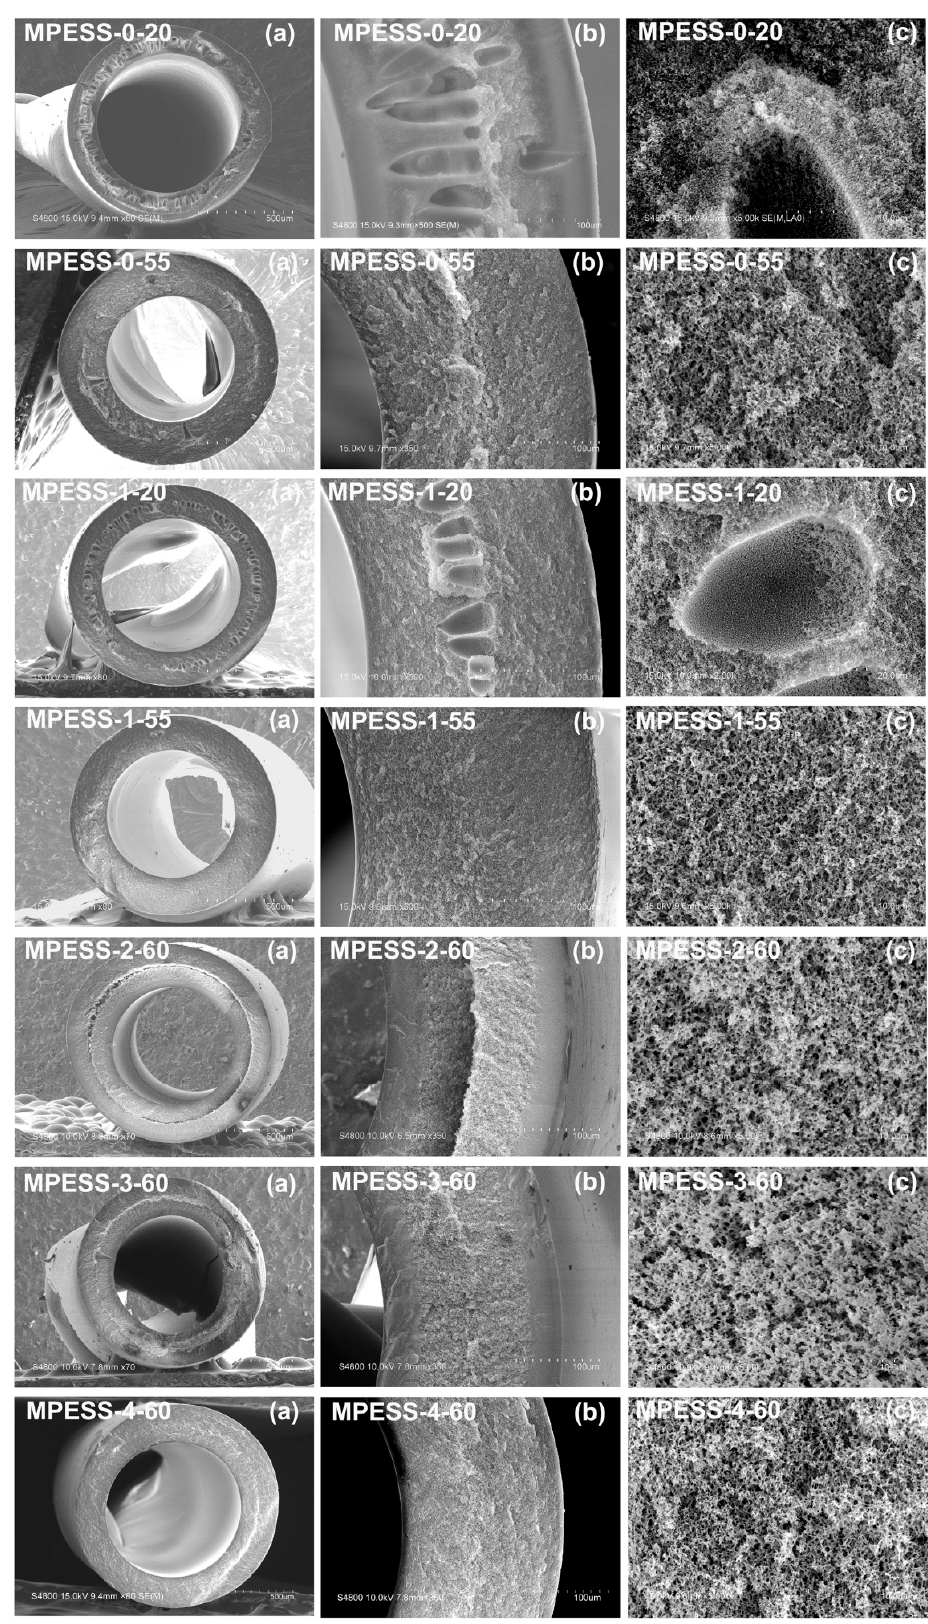
Figure 4. SEM micrographs of the PES hollow fiber membranes. ( a ) full cross-section; ( b ) part of cross-section; ( c ) enlarged cross-section.